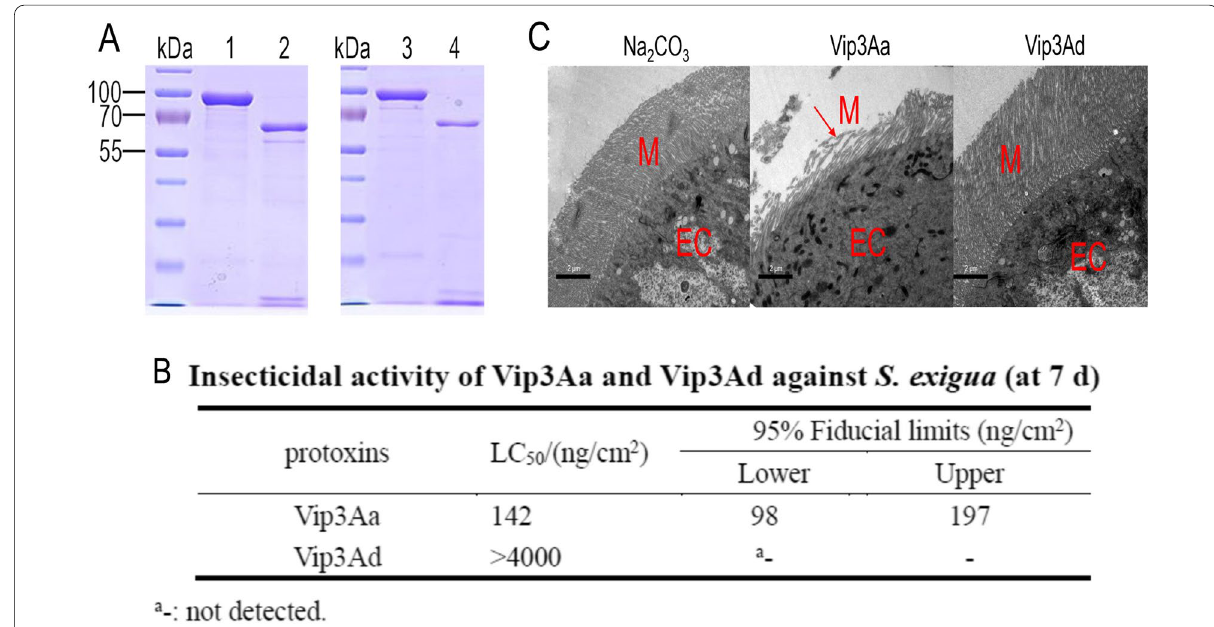
Fig. 1 Studies on the activities of Vip3Aa and Vip3Ad against S. exigua . A Expression and purification of Vip3Aa and Vip3Ad. lane 1: Vip3Aa protoxin, lane 2: Vip3Aa activated‑toxin, lane 3: Vip3Ad protoxin, lane 4: Vip3Ad activated‑toxin. B Insecticidal activities of Vip3Aa and Vip3Ad against S. exigua .